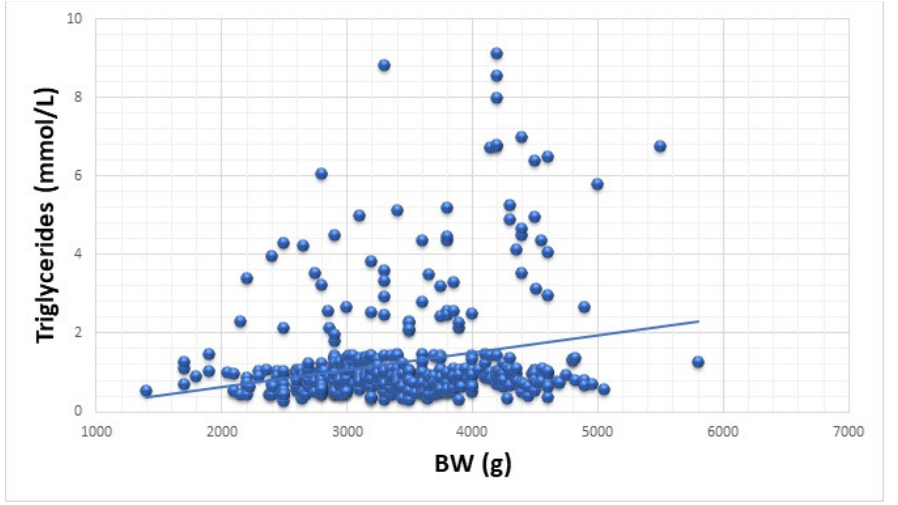
Figure 3. Correlation between BW and triglycerides.